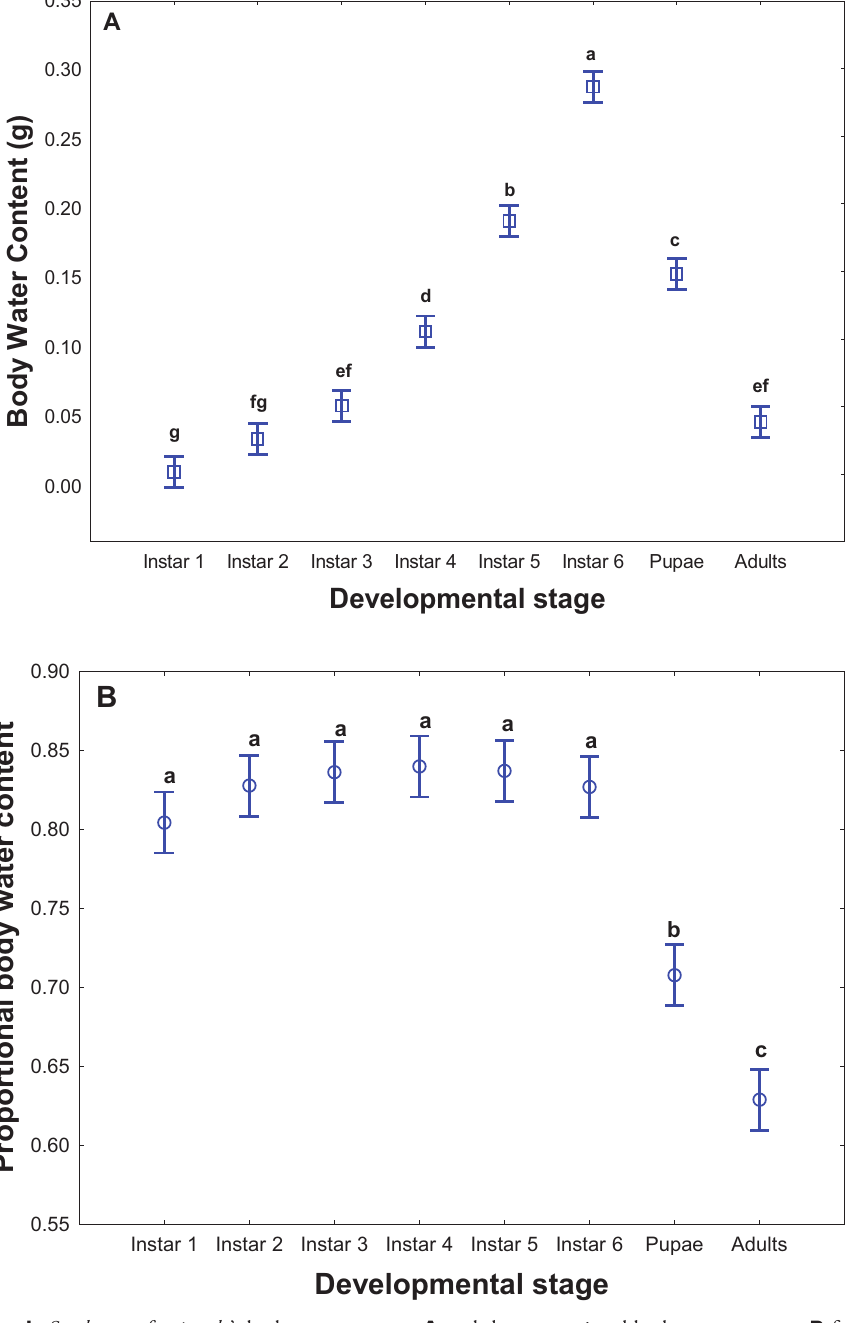
Figure 1. Spodoptera frugiperda ’s body water content A and the proportional body water content B for larvae (all six instars), pupae and adults (48 h old). Error bars represent 95% confidence limits (N = 20). Means with the same letter are not significantly different from each